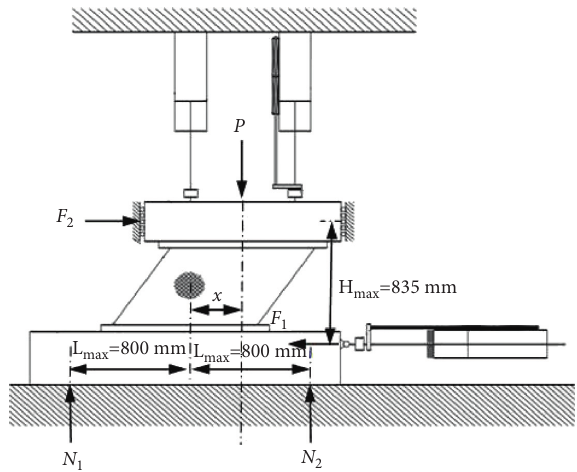
Figure 2: Force of the specimen in the process of compression and